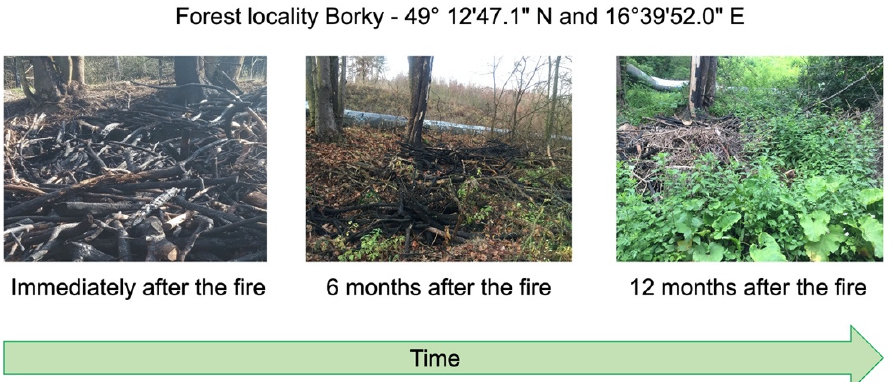
Figure 1. Site hit by fire immediately, 6 months, and 12 months after the fire. The location has been monitored under a long ‐ term research project.